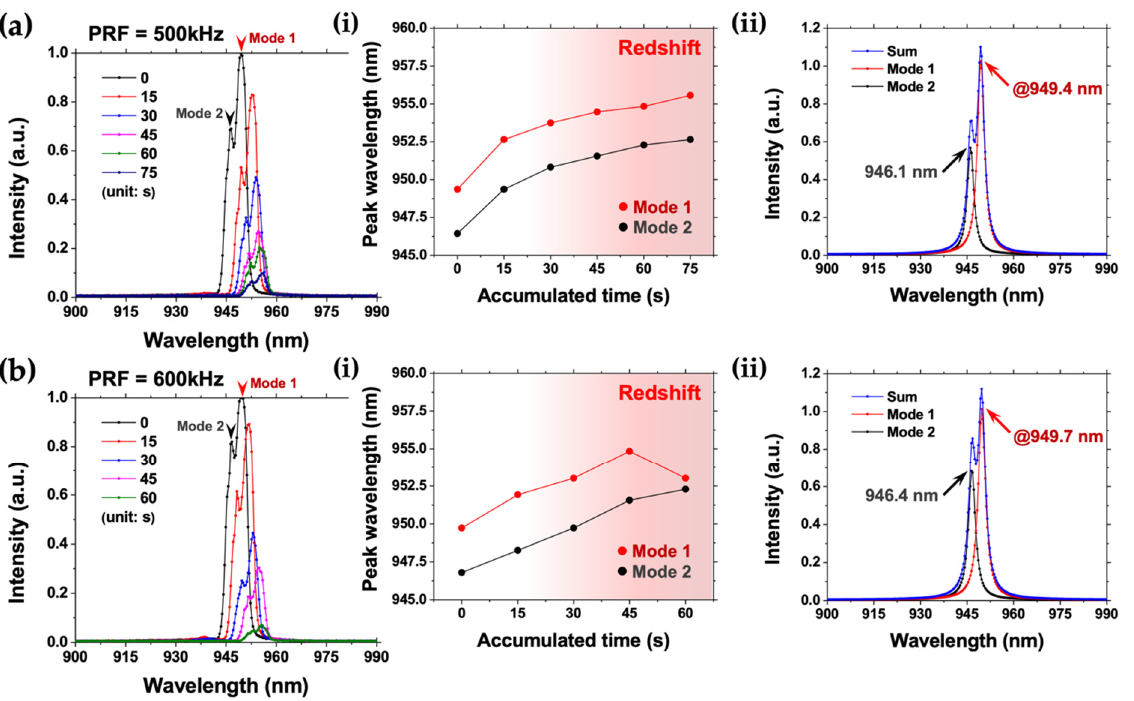
Figure 7. Reliability test for the integrated system and the corresponding light emission spectra of the employed PCSEL operated with a fixed pulse width of 50 ns. ( a ) Sequence of light emission spectra of the PCSEL operated at 500 kHz for comparison. Inset: ( i ) Corresponding center wavelengths extracted from ( a ). An obvious redshift can be observed in the process of time. Within 75 s, the corresponding center wavelengths of Mode 1 and Mode 2 shift from 949.36 nm to 955.57 nm and from 946.43 nm to 952.65 nm, respectively. ( ii ) Corresponding peak deconvolution of the PCSEL operated at 500 kHz with a pulse width of 50 ns. A dual-mode phenomenon can be recognized for Mode 1 and Mode 2 with the corresponding center wavelengths of 949.4 nm and 946.1 nm, respectively. ( b ) A sequence of light emission spectra of the PCSEL operated at 600 kHz for comparison. Inset: (i) Corresponding center wavelengths extracted from ( b ). Within just 60 s, the corresponding center wavelengths of Mode 1 and Mode 2 shift from 949.73 nm to 953.02 nm and from 946.8 nm to 952.29 nm, respectively. ( ii ) Corresponding peak deconvolution of the PCSEL operated at 600 kHz with a pulse width of 50 ns. A distinct dual-mode phenomenon can be recognized for Mode 1 and Mode 2 with the corresponding center wavelengths of 949.7 nm and 946.4 nm,